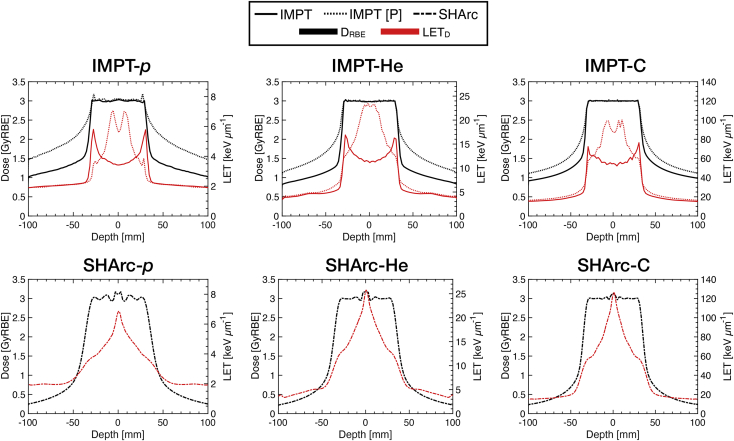
Dose and dose-averaged linear energy transfer (LETD) profiles for p,4He, and 12C using intensity modulated particle therapy (IMPT)-2F (conventional vs patch configuration [P]) plan optimization are displayed (top) with reference spot-scanning hadron arc (SHArc) plan profiles (bottom). Midtarget LET enhancement IMPT-2F[P] yields comparable values with SHArc however, IMPT-2F[P] significantly increases entrance dose, particularly for p and 4He on the order of ∼60%.